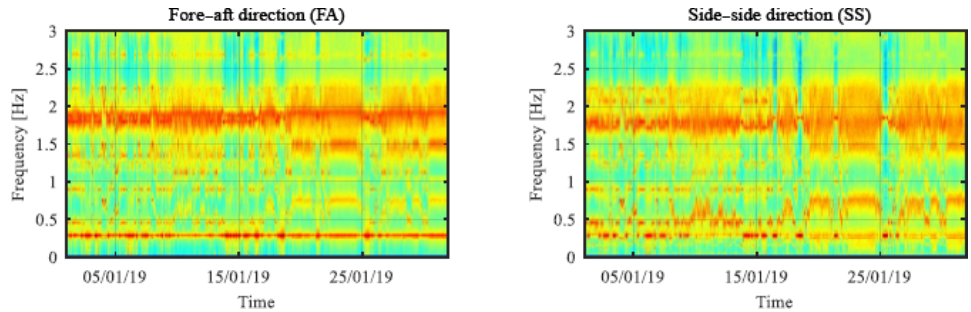
Figure 10. Colour maps with singular-value spectra for the FA and SS directions in January 2019.